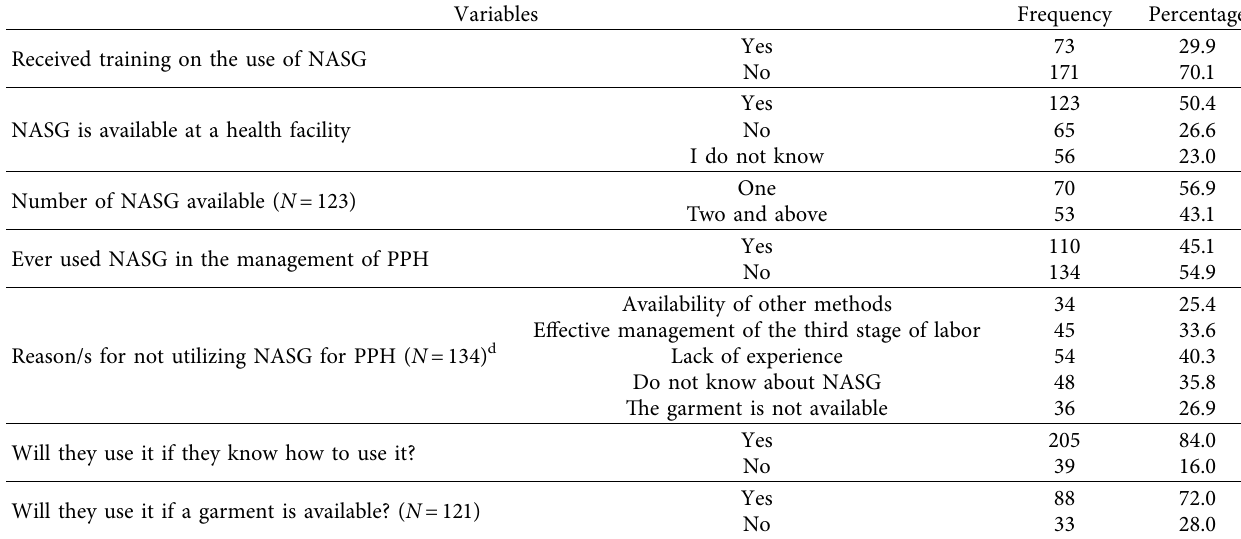
Figure 2: Utilization of NASG for management PPH among maternity ward health care professionals in South Wollo zone health facilities, North West Ethiopia, 2021. Table 4: Utilization of NASG for management of PPH among maternity ward healthcare professionals in South Wollo zone health facilities, Northwest Ethiopia,